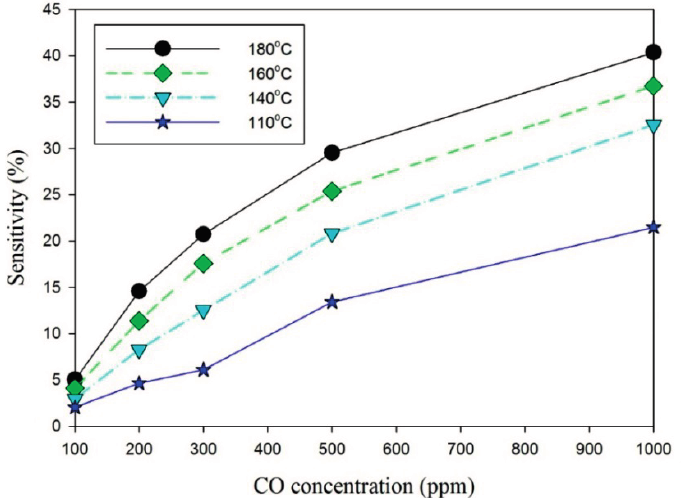
Figure 9. Relationship between CO concentrations and sensitivity of the gas sensors under various operating temperatures.